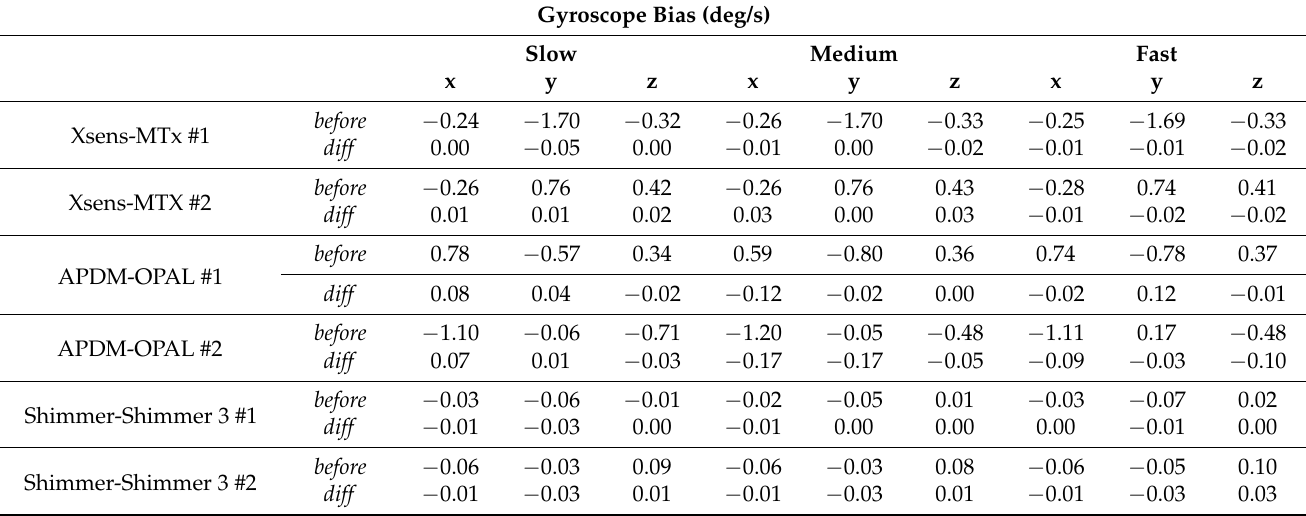
Table A4. Sensor Gyroscope Biases during the First 60 s of Static Acquisition before the Movements ( before ) and Difference ( diff ) with the Bias Record at the End of